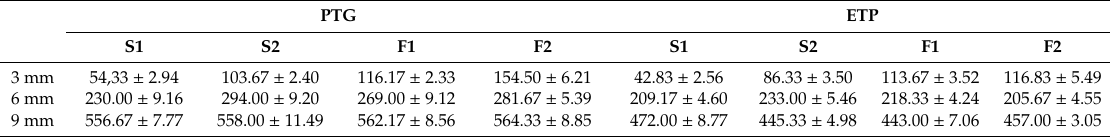
Table 2. Heat-treated alloy bending resistance test: PTG and ETP mean values (g).